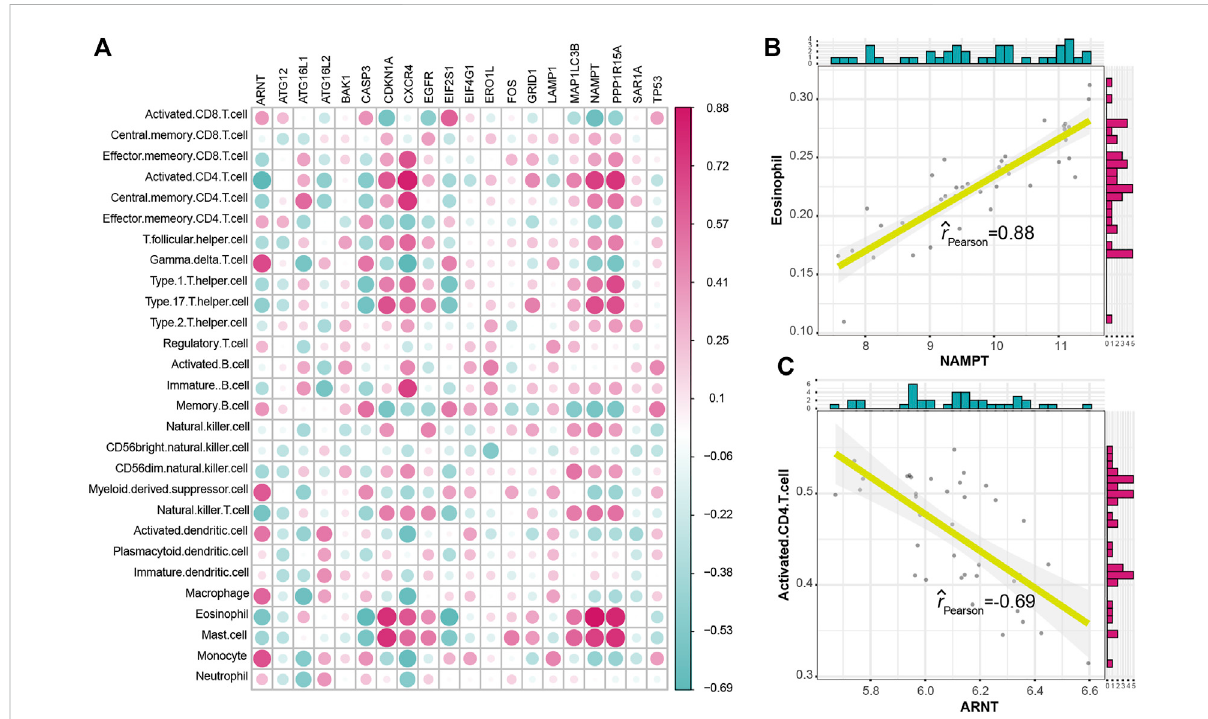
FIGURE 3 Correlation between immunocyte cells and dysregulated autophagy genes. (A) Dot plot showed the correlations between each immunocyte cell type and each dysregulated autophagy gene. (B) Most positively correlated immunocyte – autophagy gene pair. (C) Most negatively correlated immunocyte – autophagy gene